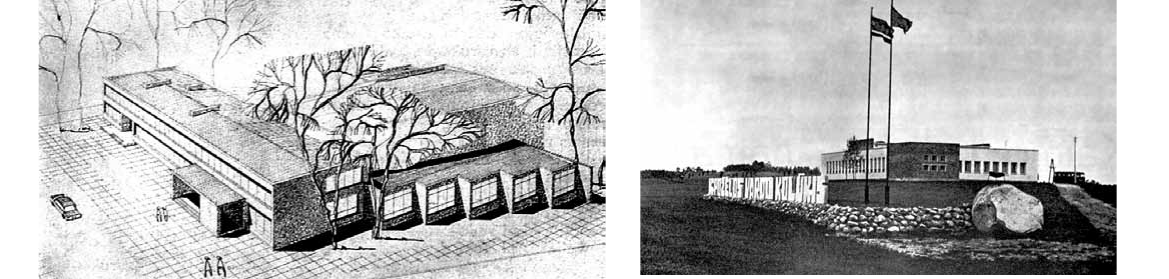
2 pav. leonpolio tarybinio ūkio (dab. Dainava) kultūros namų su 320 vietų sale individualus projektas, arch. I. Macijauskienė, 1969 m. Fig. 2. Individual project of leonpolis State farm (now Dainava) House of Culture with 320 seats, arch. I. Macijauskienė, 1969